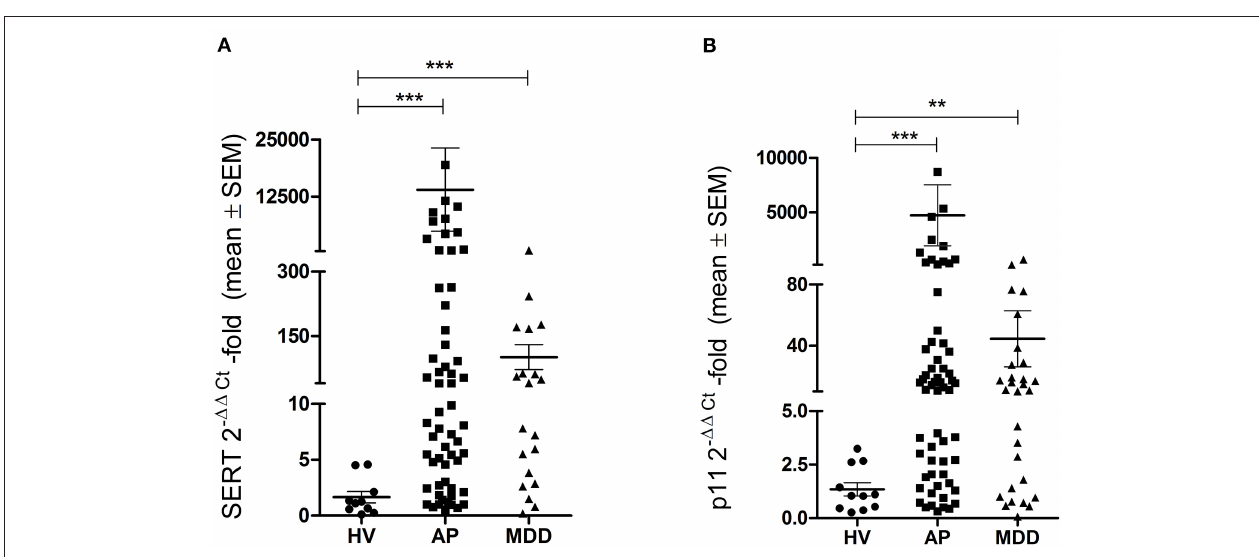
FIGURE 2 | Gene expression of serotonin transporter and p11. Quantitative real time-PCR analysis of serotonin transporter (A) and p11 (B) in healthy volunteers (HV), airline pilots (AP), and depressed patients (MDD). Relative quantification performed by 2 − 11 Ct method. Statistical analysis was performed by Kruskal-Wallis with Dunn’s multiple comparison test (** p < 0.01; *** p < 0.001). SEM, standard error of